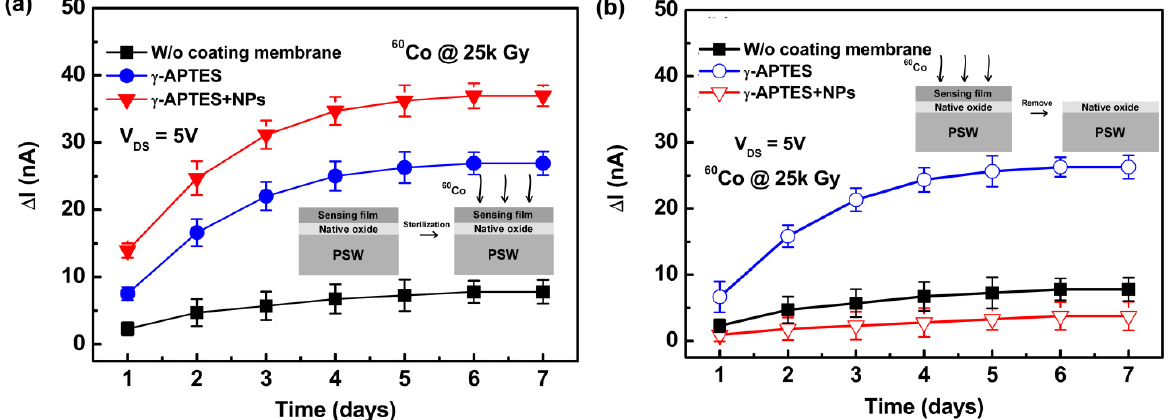
versus time curves, (a) after γ -ray sterilization for Figure 5. Channel current change Δ I DS the native-oxide/PSW, γ -APTES/native-oxide/PSW and γ -APTES+NPs/native-oxide/PSW sensors, (b) after removal of the post-irradiated γ -APTES or γ -APTES + NPs membranes. The γ -ray irradiated native-oxide/PSW without membrane coating shown in (a) is re-plotted for